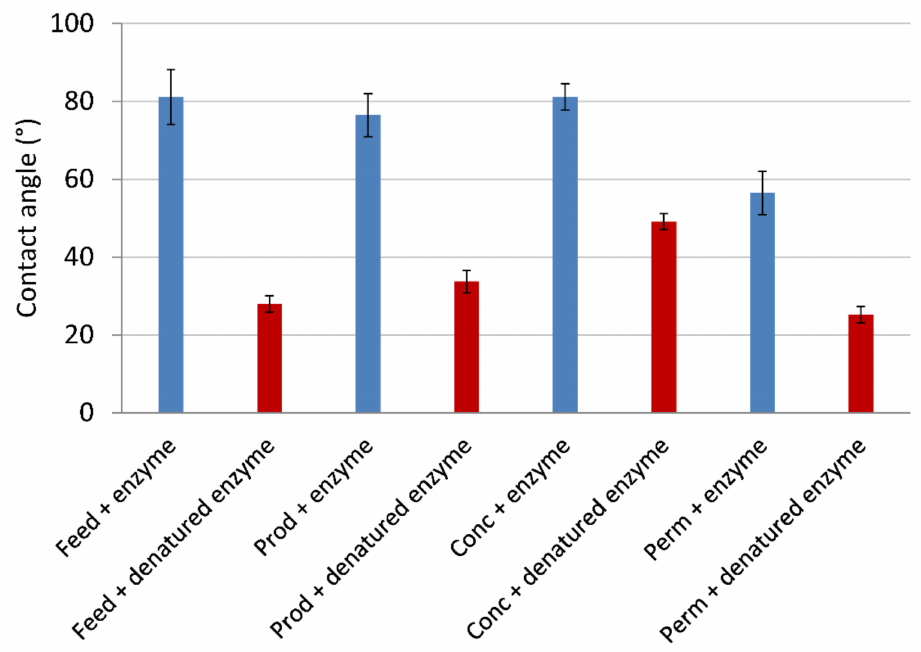
Figure 2. The water contact angle of films with different lignosulfonate preparations ( Feed , Prod , Conc , and Perm ) and active ( blue bars ) or denatured ( red bars ) laccase.